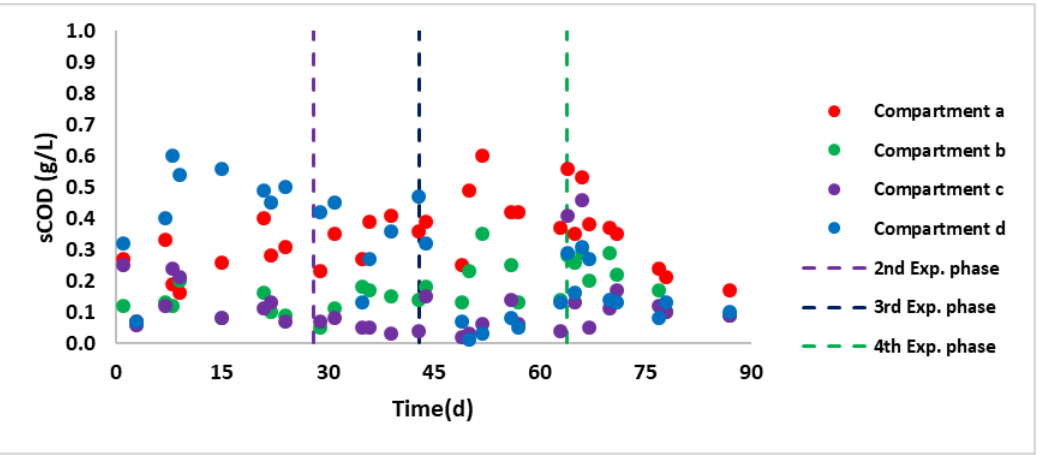
Figure 13 . Daily sCOD values of PABR compartments.